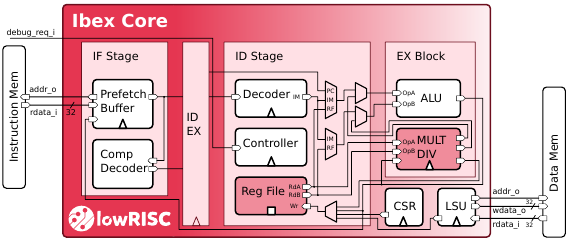
Figure 1: Ibex RISC-V Core